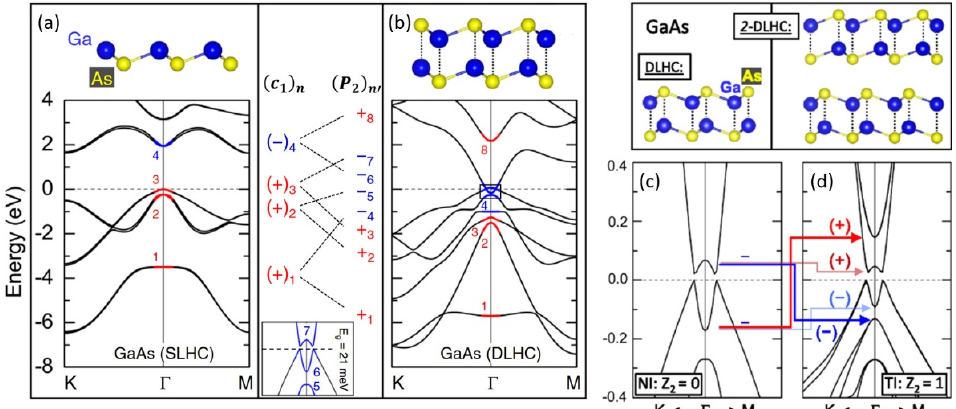
Figure 5. Atomic and band structures of ( a ) SLHC and ( b ) DLHC GaAs by HSE calculations. Inset highlights the band inversion of ( b ). The red means even parity and blue means odd. Band structure of ( c ) DLHC and ( d ) 2-layer DLHC GaAs. Reproduced with permission [30]. Copyright 2018, American Physical Society.